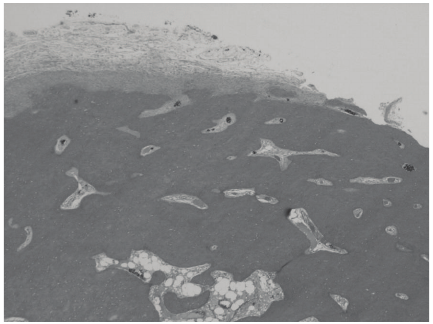
Figure 4: Histological examination of the tumor (H&E × 20). The tumor consisted of mature lamellar bone without a fibrous component. Bone marrow cells and trabeculae were confirmed in the center of the